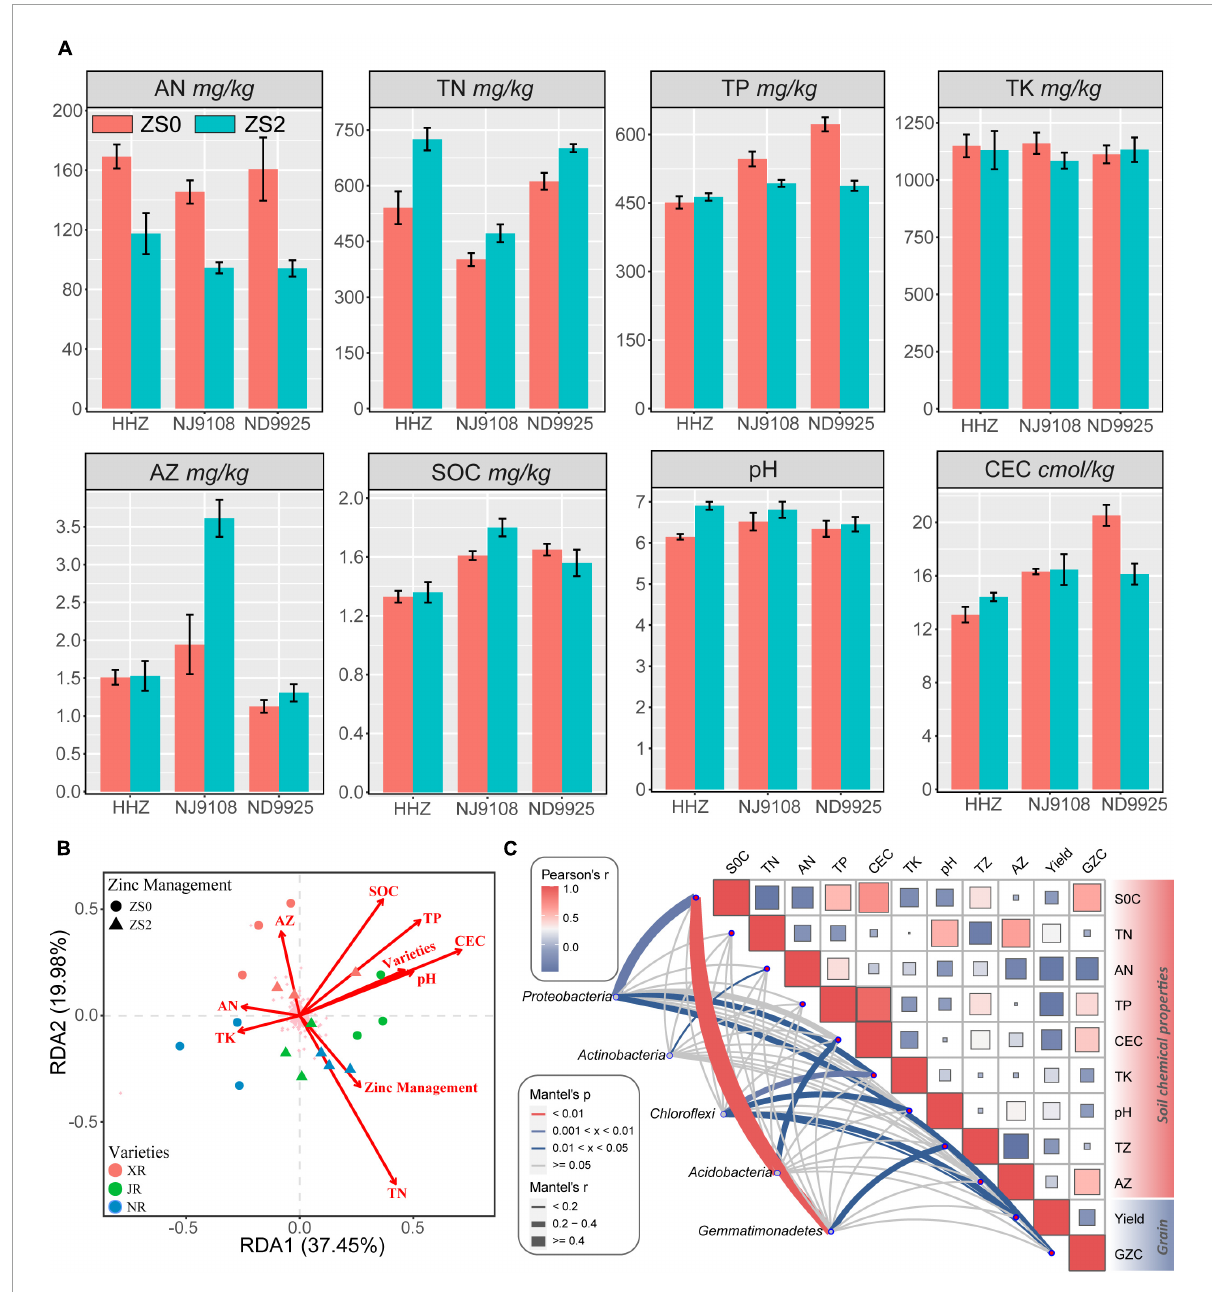
FIGURE5 (A) Soil properties at the top 15 cm layer in the experimental fields. SOC, soil organic carbon; TN, total nitrogen; AN, available nitrogen; TP, total phosphorus; TK, total potassium; CEC, cation exchange capacity; AZ, available zinc; ZS0, without basal zinc fertilization; ZS2, with basal zinc fertilization. (B) The relation among the bacterial community, environmental parameters, and varieties of rice and soil Zn application. Redundancy analysis (RDA) of the correlation between the bacterial community (OTU level) and soil chemical properties. Red lines represent significant factors, and the pink crosses represent OTUs; (C) correlations between soil chemical properties, grain yield, grain zinc content (GZC), and dominant bacterial phyla (with a total relative abundance > 3%). The relative abundance of dominant bacterial phyla based on Bray–Curtis distance is related to other factors by Mantel’s test. Line width indicates the Mantel’s r statistic, and color denotes the significance based on 999 permutations. The color gradient in heatmap corresponds to Pearson’s correlation